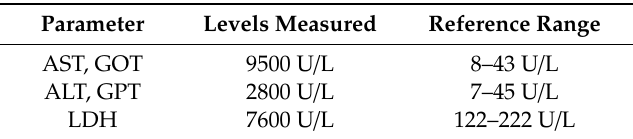
Table 2. Aspartate aminotransferase (AST, GOT), alanine aminotransferase (ALT, GPT) and lactate dehydrogenase (LDH) in serum of patient 2, measured on day 4 of hospitalisation. Parameter Levels Measured Reference Range